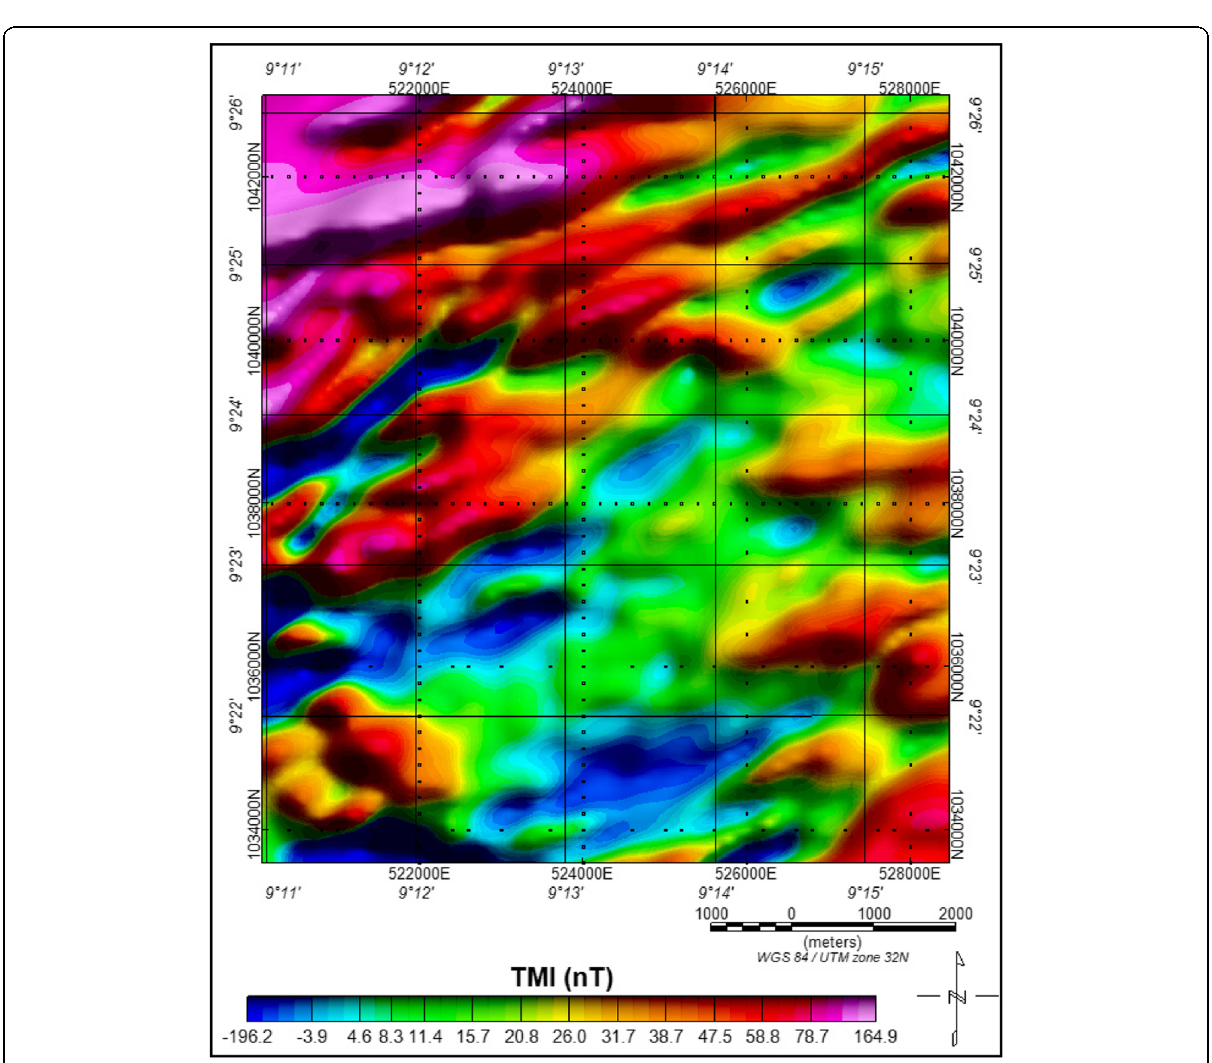
Fig. 17 TMI (Total Magnetic Intensity) anomaly map of the study